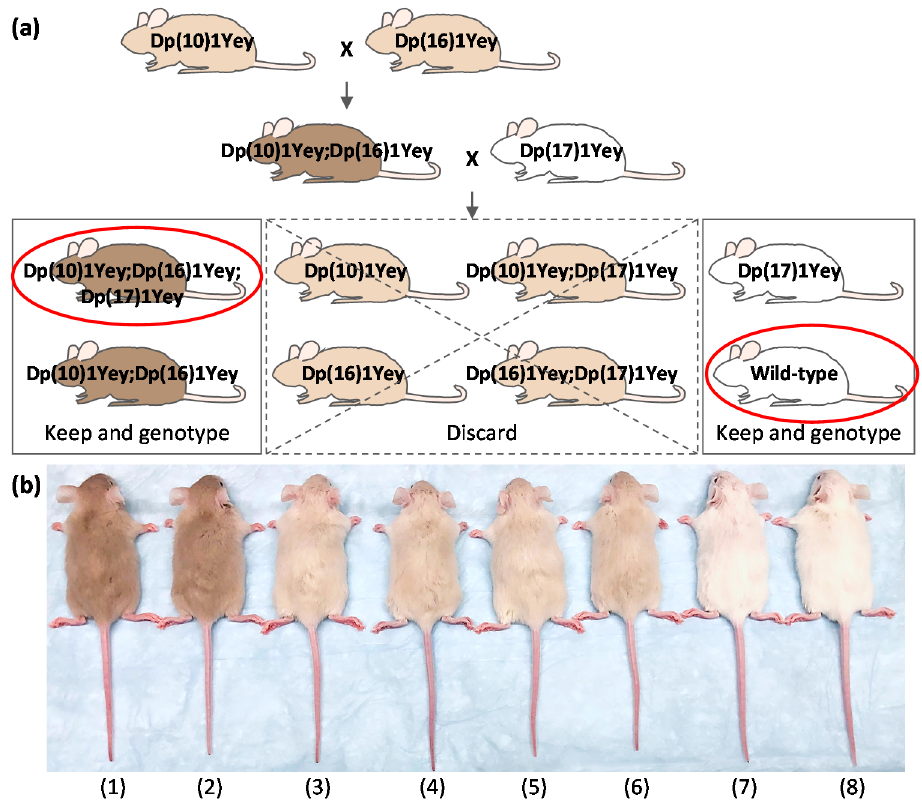
Figure 2. Coat color-facilitated strategy to identify the triple compound model of Down syndrome (DS). ( a ) A Dp(10)1Yey mouse with a cream coat color is crossed to a Dp(16)1Yey mouse with a cream coat color to produce a Dp(10)1Yey;Dp(16)1Yey mouse with a tan coat color. Further crossing of